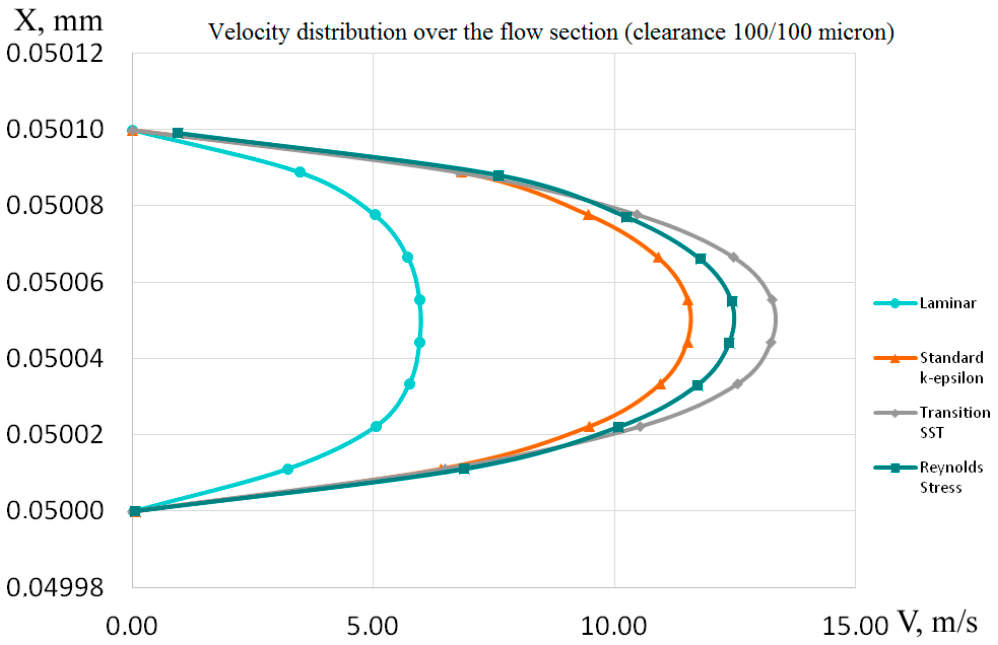
Figure 7. Velocity distribution over the flow section.